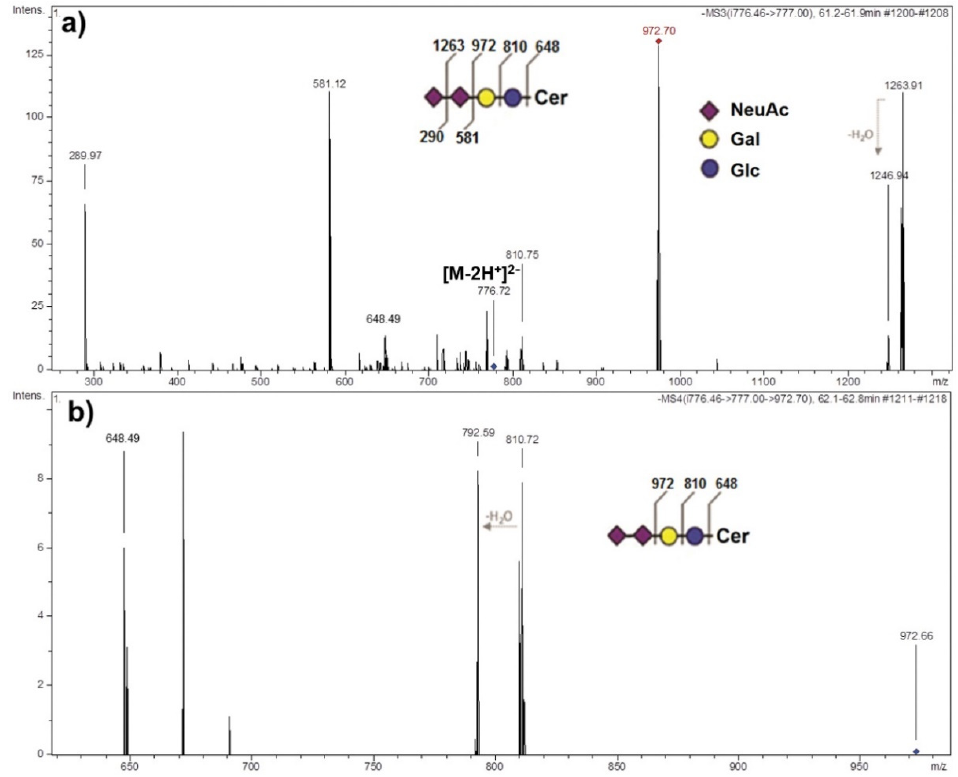
Figure 3. Fragmentation spectra obtained via multistage CID MS 2 ( a ) and MS 3 ( b ) of the [M-2H + ] 2 − ion at m/z 776.46 confirming the GD3 (d18:1/24:0) structure in the ganglioside mixture from anaplastic ganglioglioma tumor tissue.